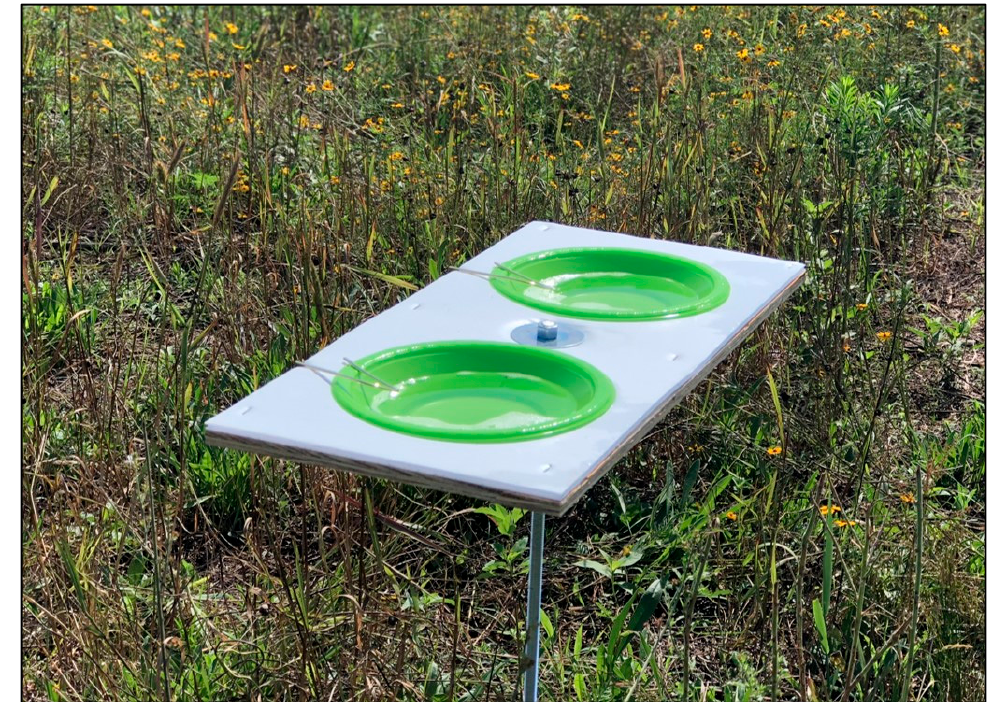
Figure 1. A colored pan trap platform used in the study. Picture by N. Joshi.